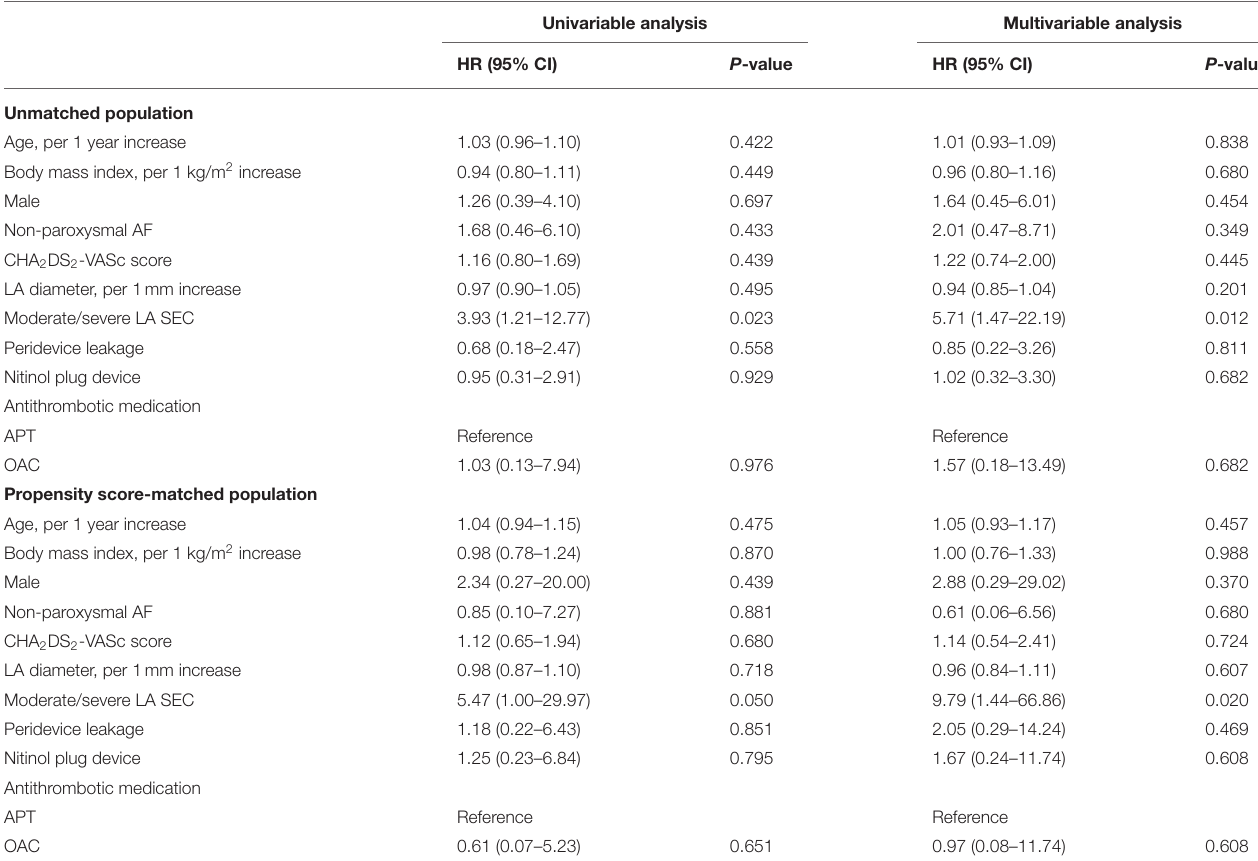
TABLE 5 | Univariable and multivariable analysis (Cox regression model) for predictors of